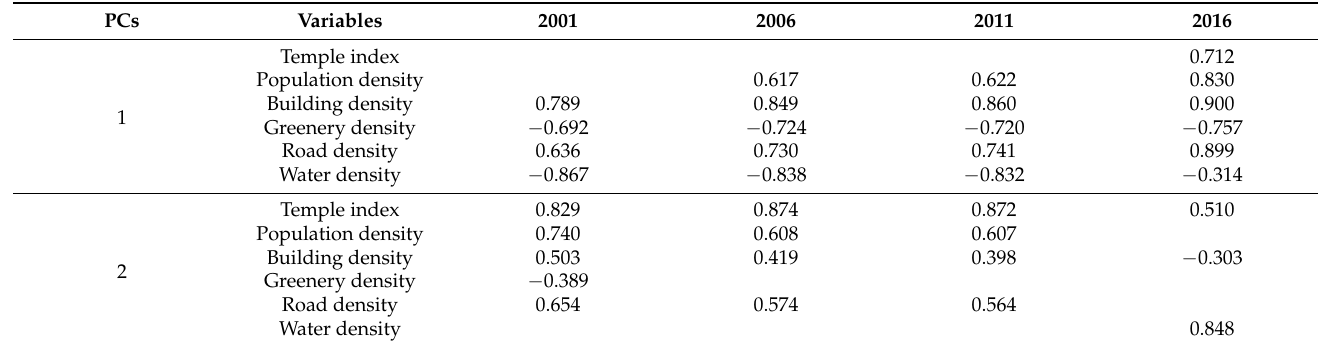
Table 4. Rotated Components (variable values of each PC; in 2001, the sub-factors include building density, water density, temple index, and population density; in 2006 and 2011, they comprised of building density, greenery density, the and temple index; while all factors were as considered sub-factors for 2016).